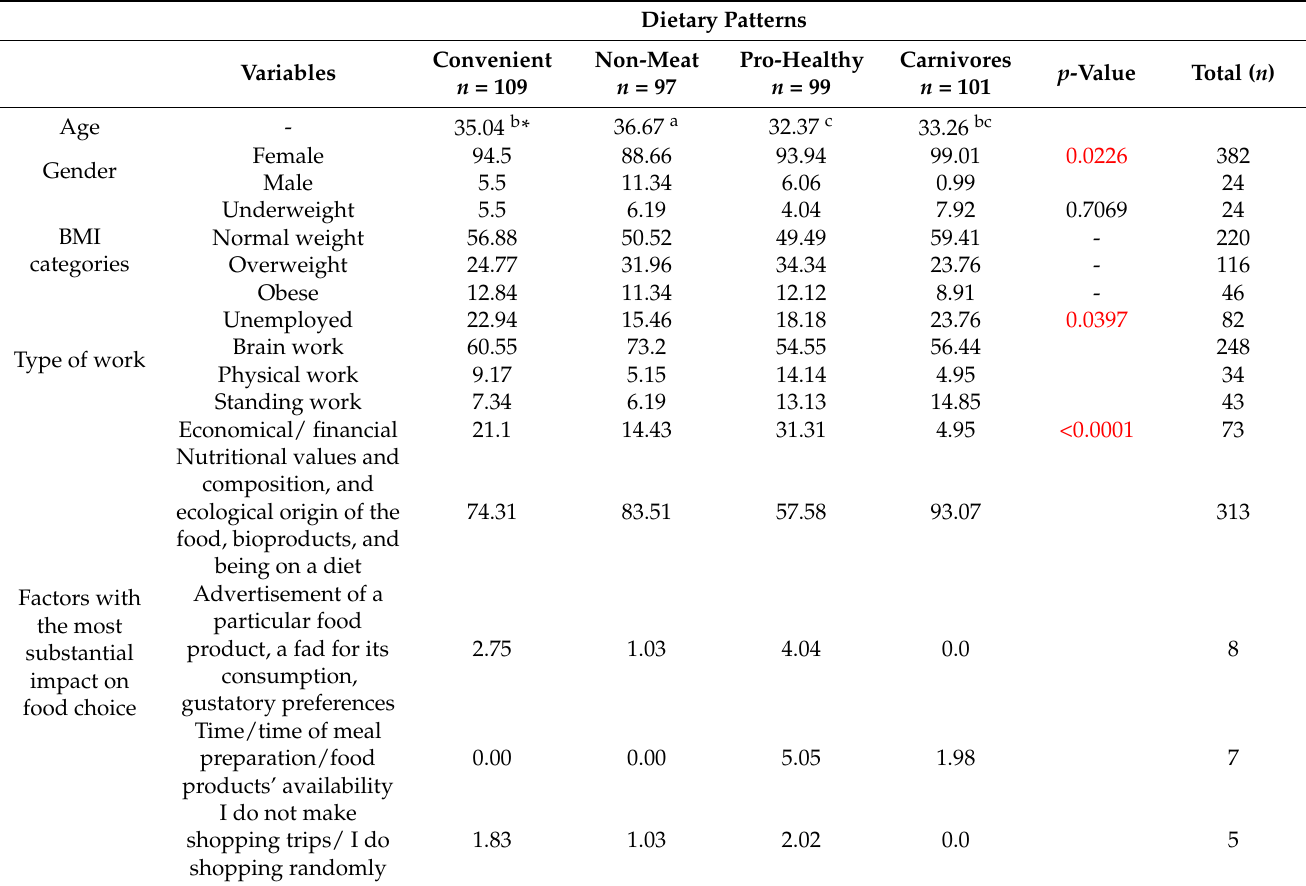
Table 3. Characteristics of respondents by dietary patterns